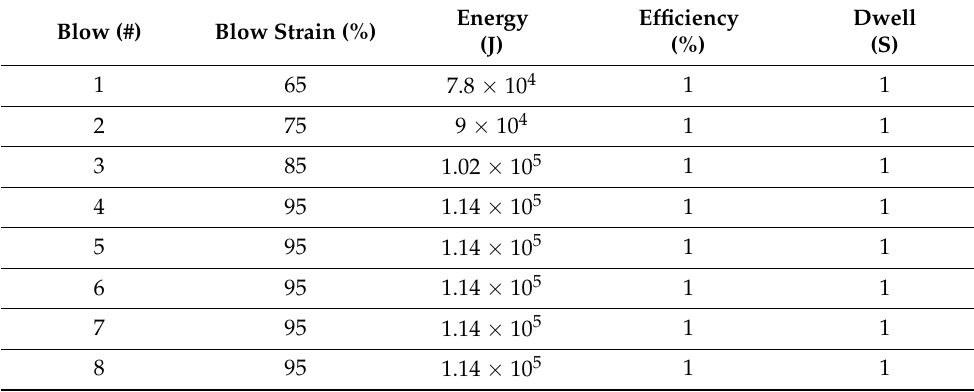
Figure 4. Schematic representation of 18CrNiMo pinion shaft forging process. Dimensions in mm. Table 2. Blow table of the actual process.